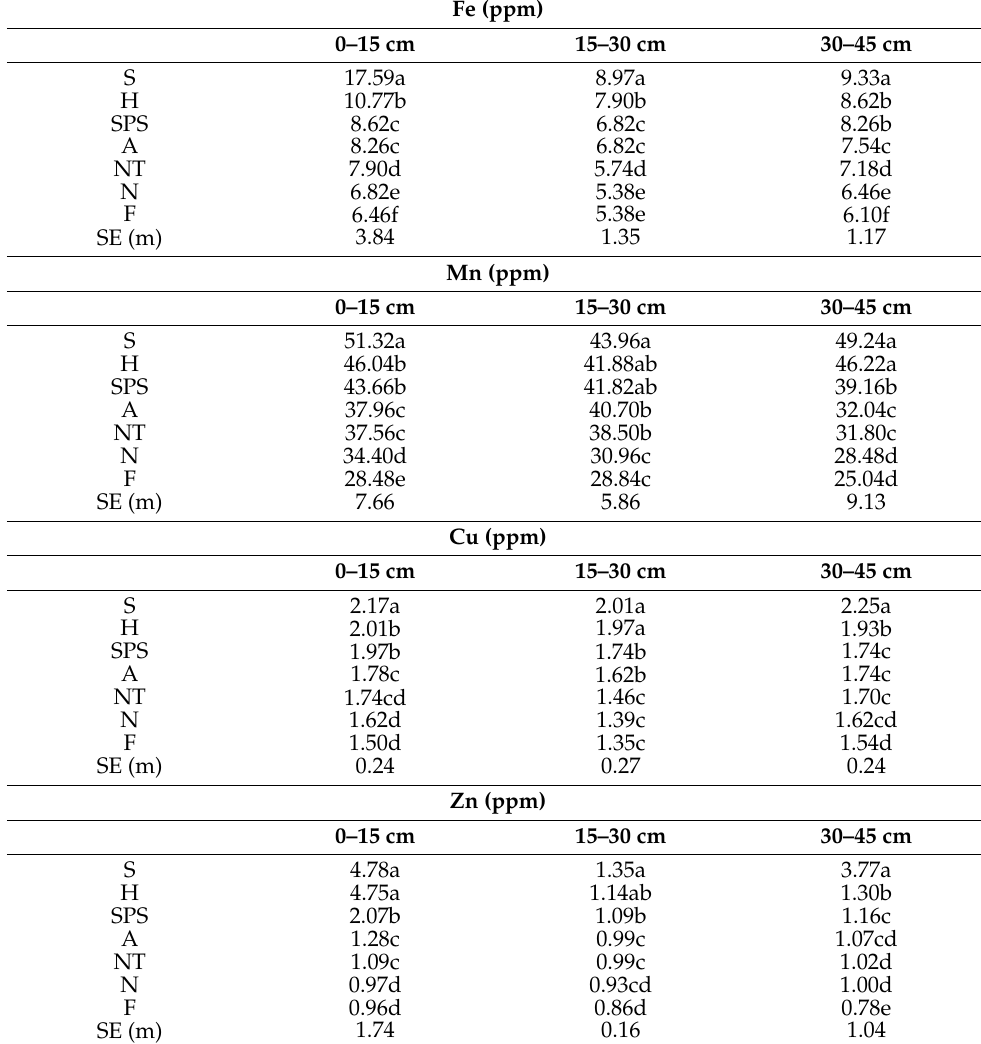
Table 4. Iron (Fe; ppm), manganese (Mn; ppm), copper (Cu; ppm), and zinc (Zn; ppm) in surface (0–15 cm) and subsurface (15–30 cm and 30–45 cm) soil layers, as influenced by different LUS in semi-arid environment. Means with similar lowercase letters within a column are not significantly different at p < 0.05 according to LSD test. See Materials and Methods for detailed information on